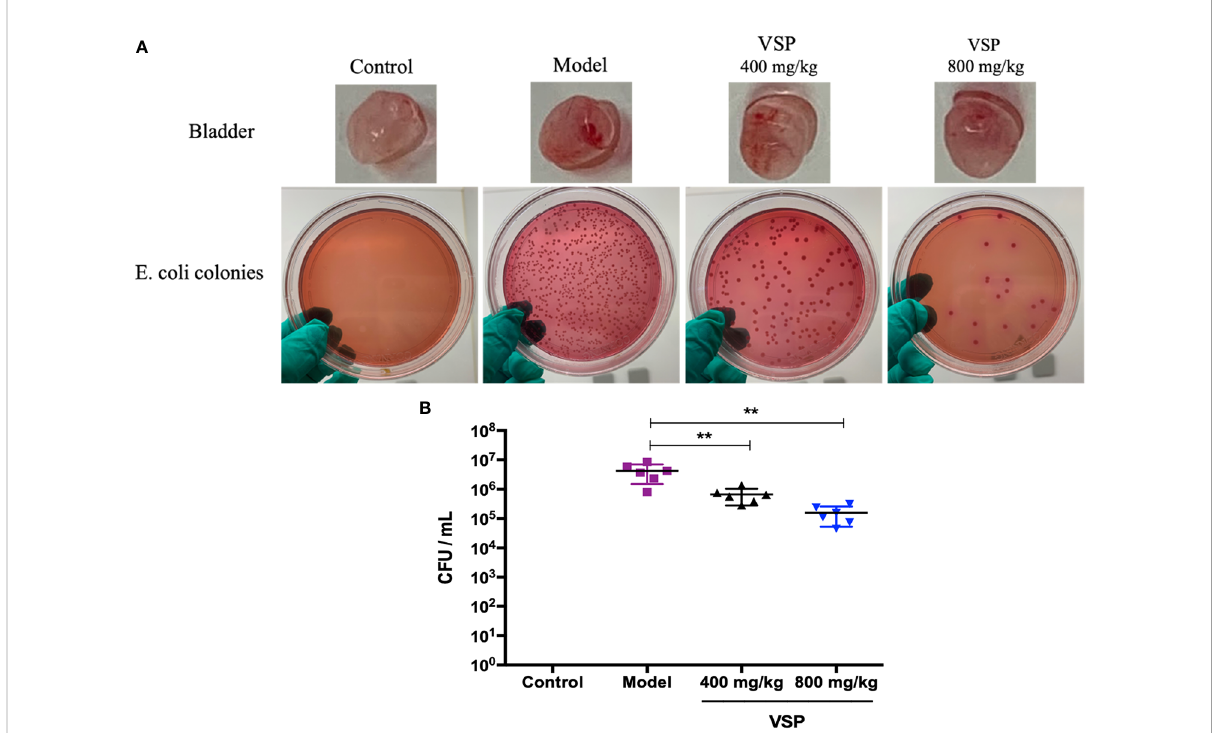
FIGURE 5 VSP reduced bacteria in the mouse bladders. (A) , The bladders of the mice were homogenized, diluted, and plated on MacConkey agar to determine bacterial counts. (B) , The results are presented as log 10 CFU/mL. Each data point represents a sample from an individual mouse, and the horizontal line indicates the median. n =6 mice per group, compared with the model group: ** p < 0.01, the results were determined by the Mann-Whitney